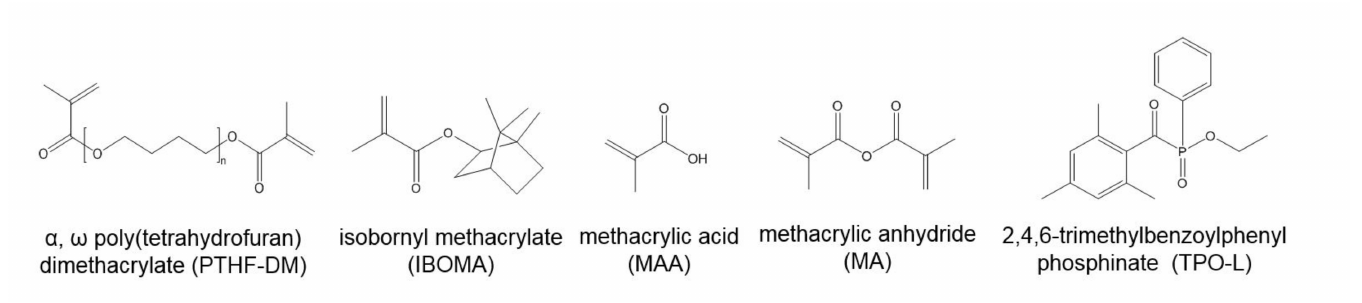
Figure 2. Chemical structures of methacrylate monomers and photobleaching initiator used in FPP-resins. Table 1. Monomer composition of FPP-resins. Each resin contains 1.0 wt.%